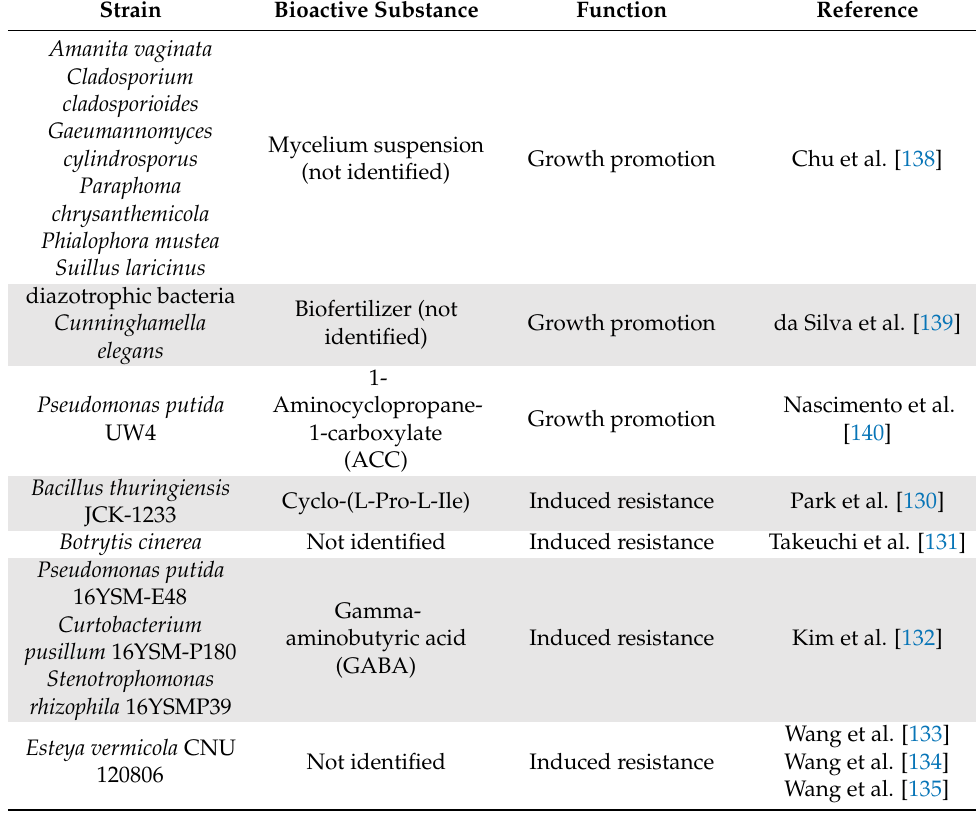
Table 3. Biocontrol microorganisms targeting pine